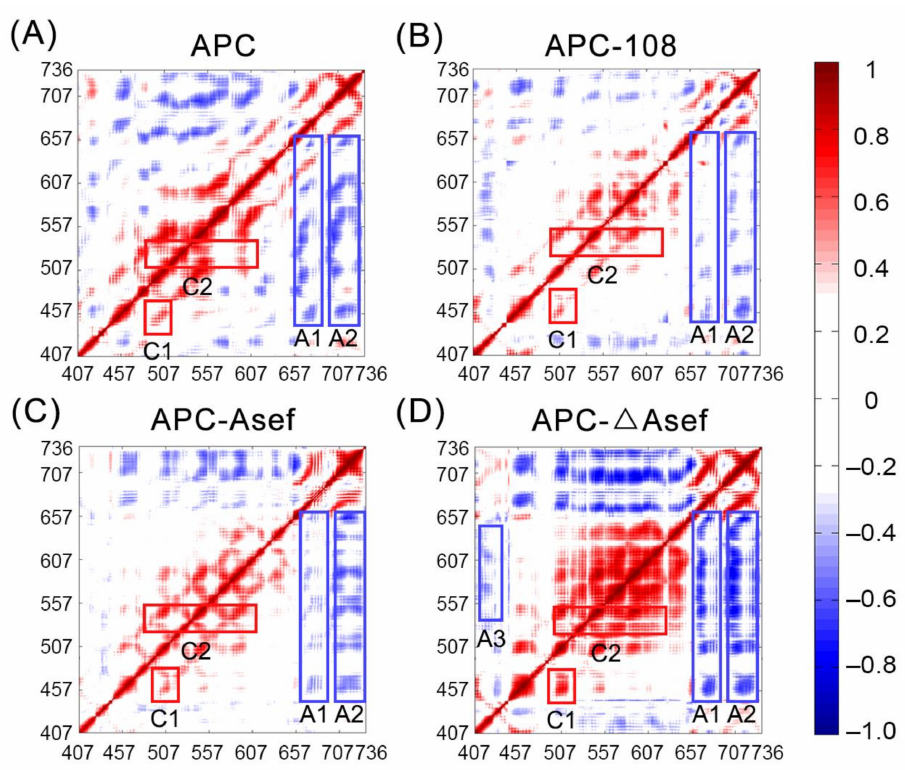
Figure 6. The dynamic cross-correlation matrixes (DCCM) of APC ( A ), APC-108 ( B ), APC-Asef ( C ), and APC- ∆ Asef ( D ). Red rectangles (C1–C2) show important correlated areas, while blue rectangles (A1–A3) show areas with clear anti-correlations. The interactions with an absolute correlation coefficient of less than 0.3 are colored white for